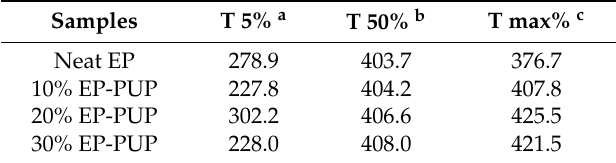
Table 2. Temperatures of different weight loss rates.